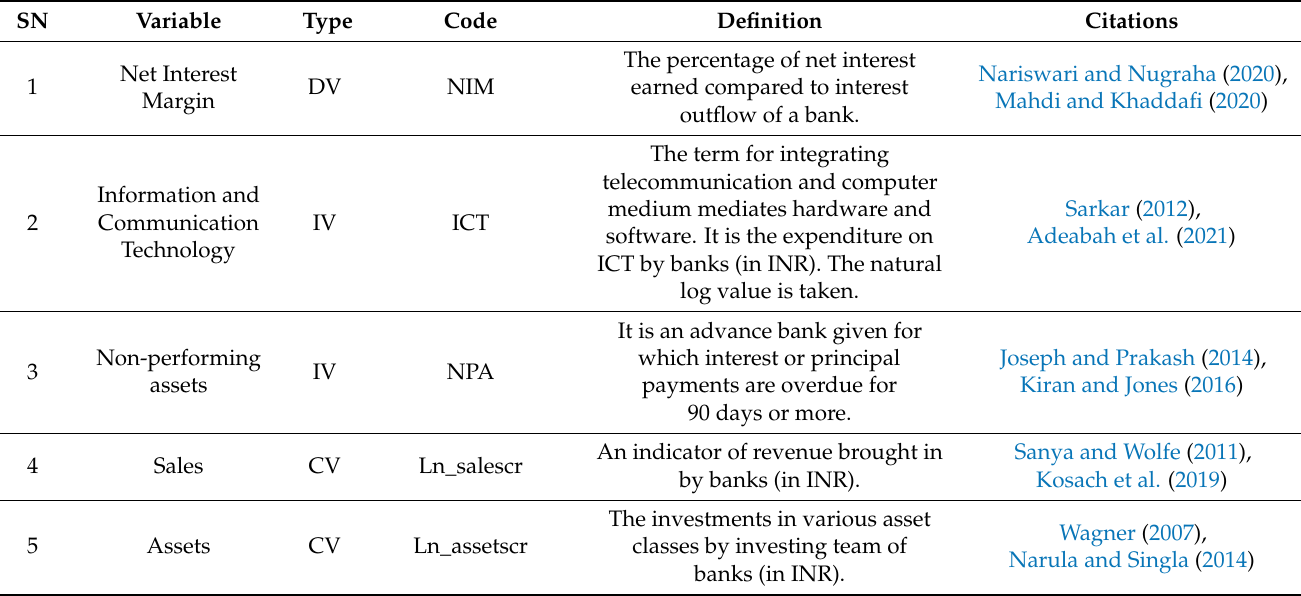
Table 1. List of